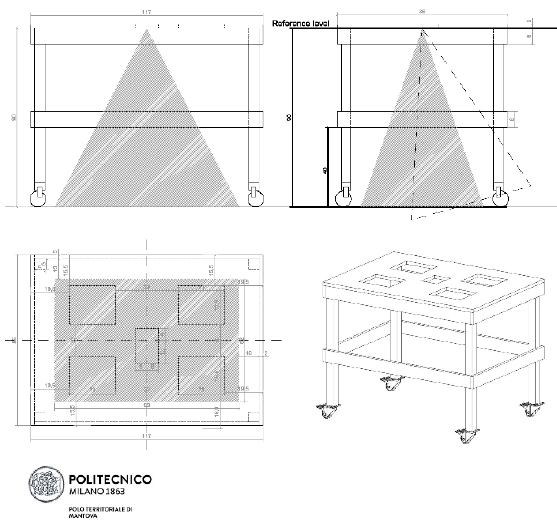
Figure 1. technical drawings of the cart. The starting dimension for the design is the height from the reference level of the camera system, set to guarantee a constant known GSD dimension. The grey area is the cone of view of the digital camera, and the dashed line in the transversal section (upper right) represents the possibility of small camera tilting. The height of the reinforcement bars in the bottom of the cart depends on the rotation of camera acquisition.